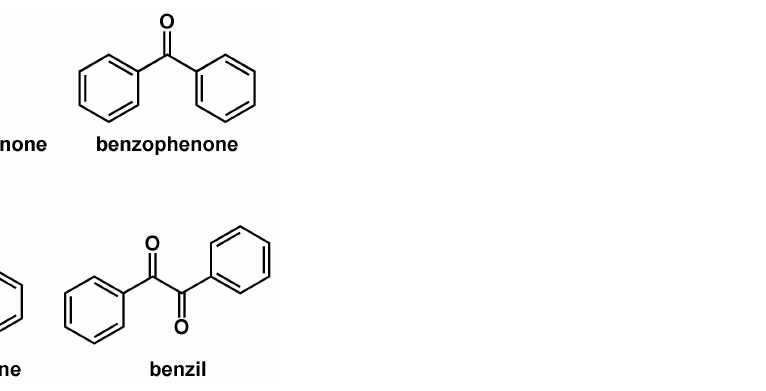
Figure 8. Chemical structures of common type II photoinitiators (the proton donors are not repre- sented